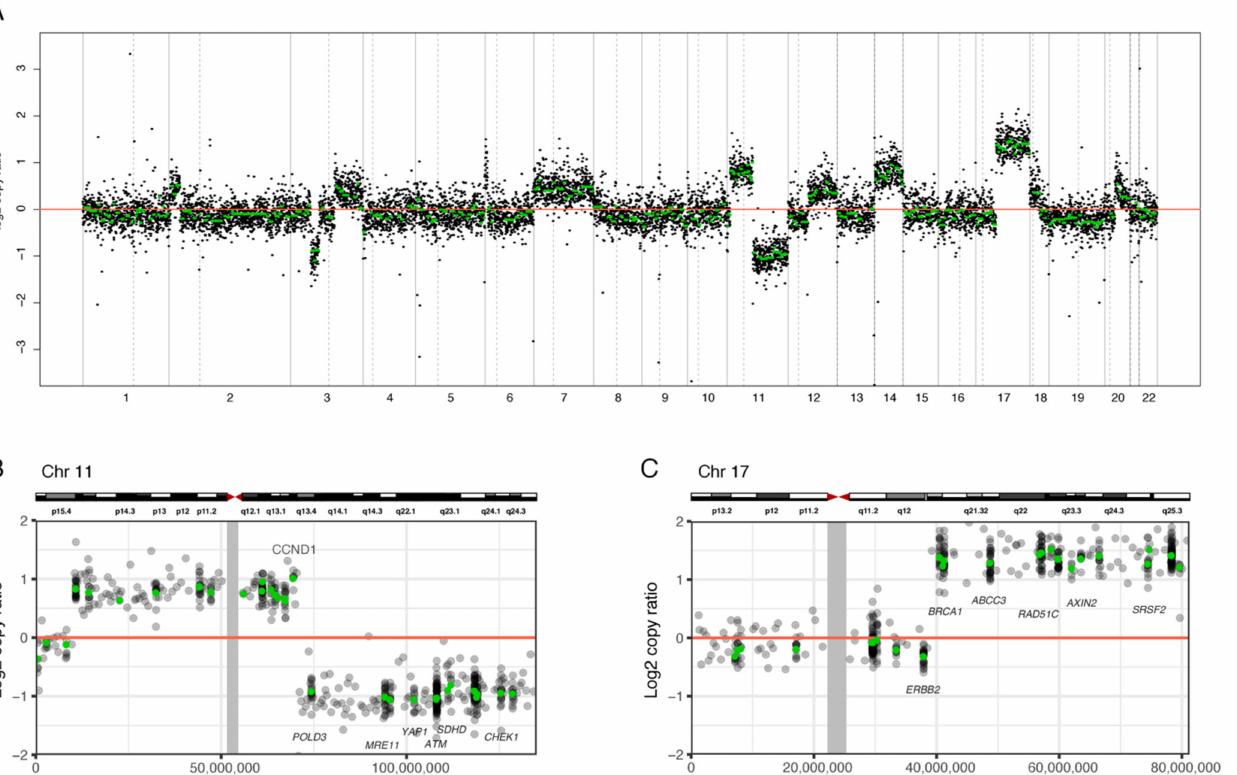
Figure 1. A representative copy number plot of NGS, showing 11q deletion, 17q gain, and no 1p deletion (Case No. 21). ( A ) Copy number plot for whole chromosome. Dashed line shows the location of the centromere. The exact position of the copy number change in chromosome 11 and chromosome 17 is shown in ( B , C ) respectively. Green dots represent the copy number of target genes. Gray line shows the location of the